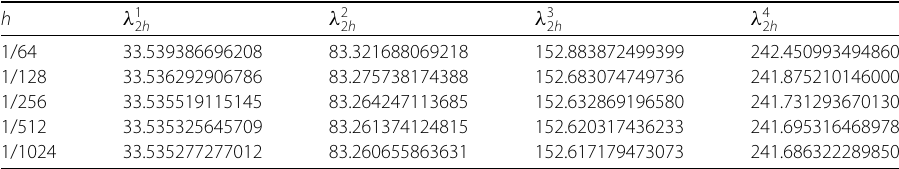
Table 6 The first four eigenvalues for l = 2 and different h with a = 0